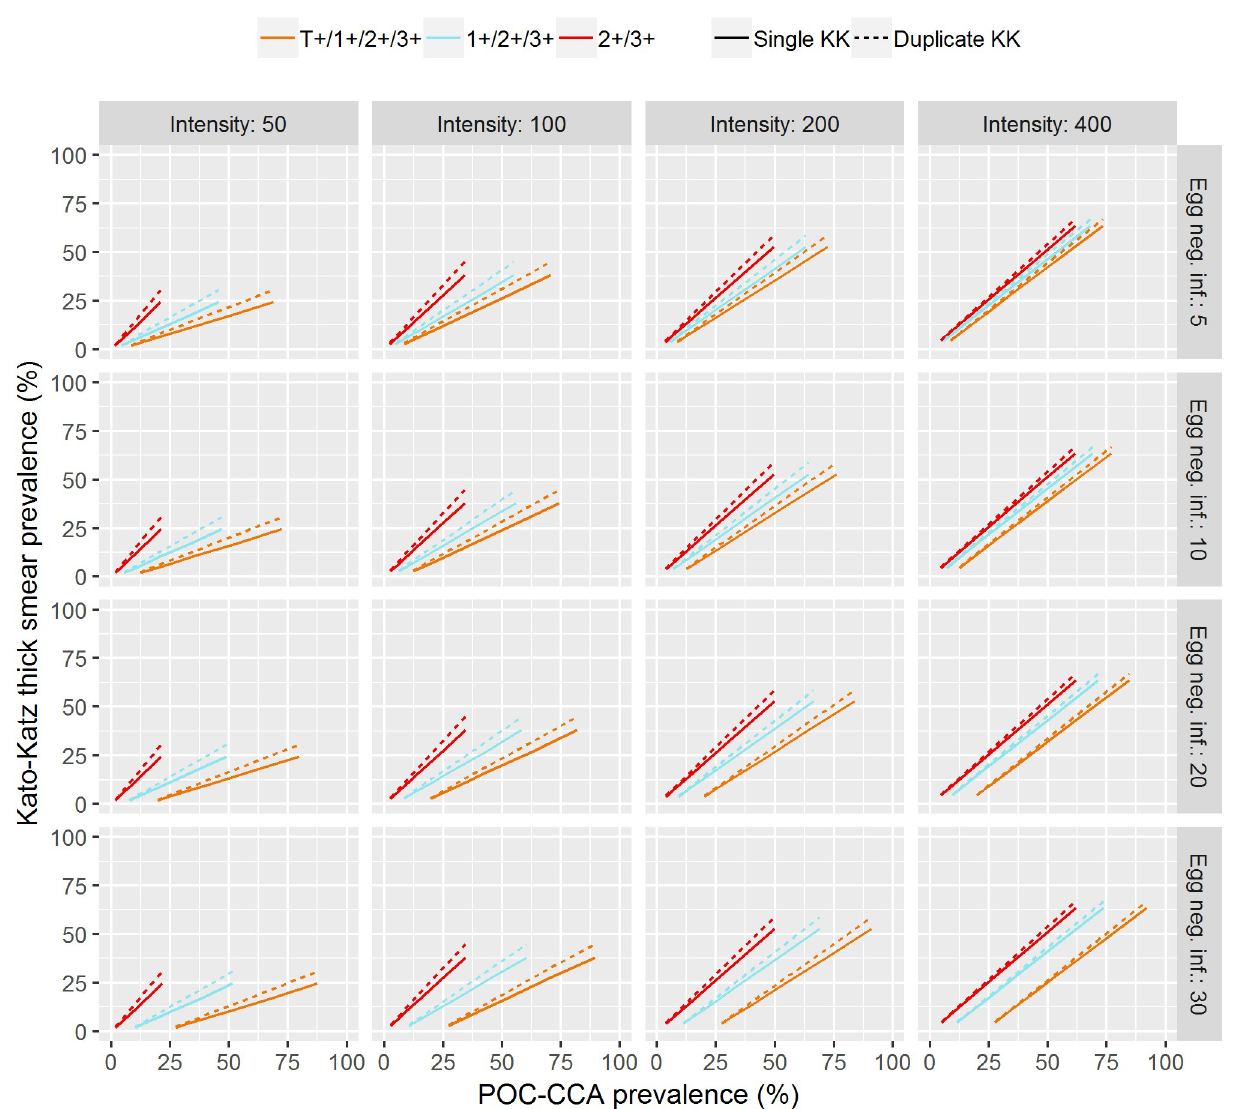
Fig 5. Predictions of the dependence between Kato-Katz and POC-CCA prevalence for various infection intensities and prevalence of egg-negative cases. Infection intensity is given in EPG and egg-negative prevalence in